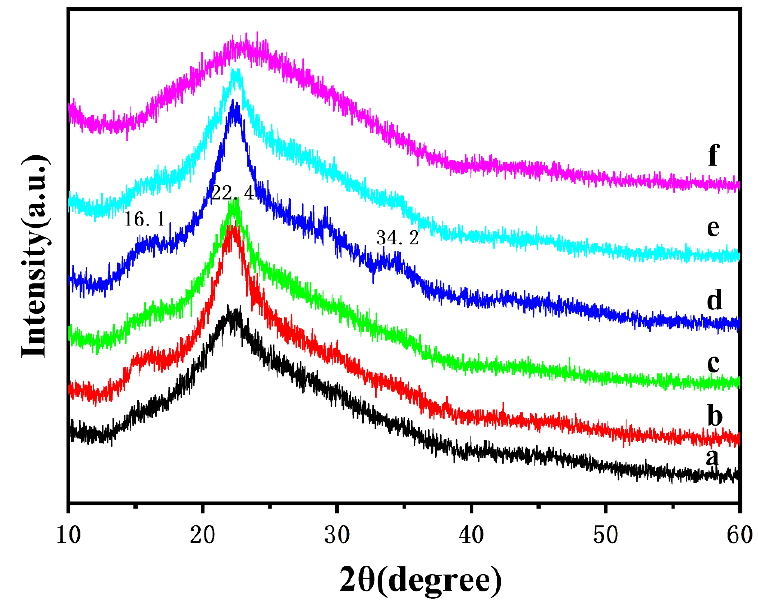
Figure 6. XRD patterns: ( a ) rice straw powder, ( b ) pretreated rice straw, ( c ) pretreated rice straw after secondary washing by C 2 H 5 OH/H 2 O solution, ( d ) rice straw-derived coarse cellulose, ( e ) RSC, ( f ) RSCA.